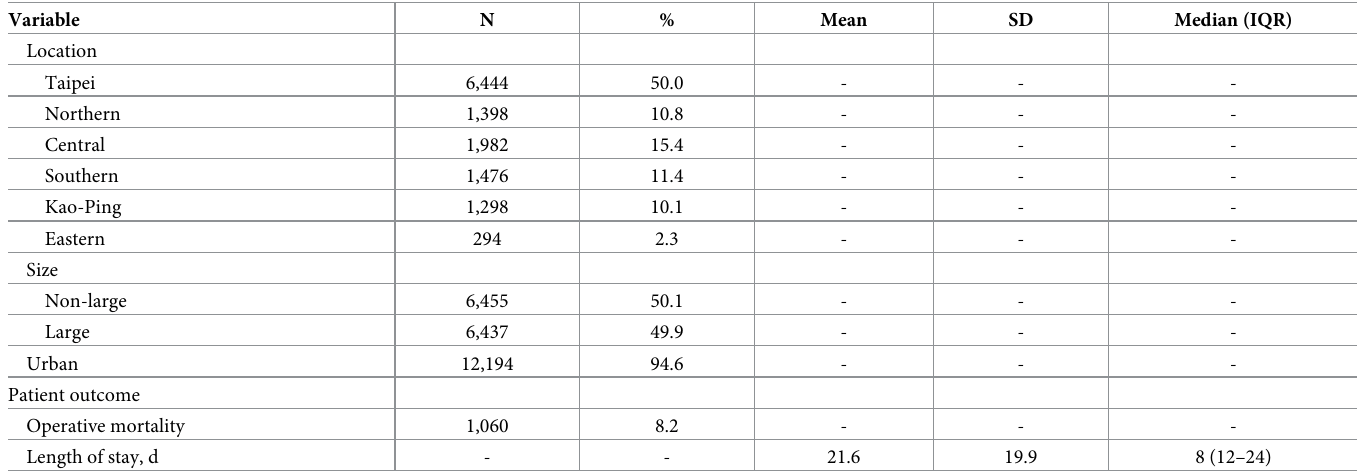
COPD indicates chronic obstructive pulmonary disease; IMA, internal mammary artery; IQR, interquartile range; PCI, percutaneous coronary intervention; SD, standard